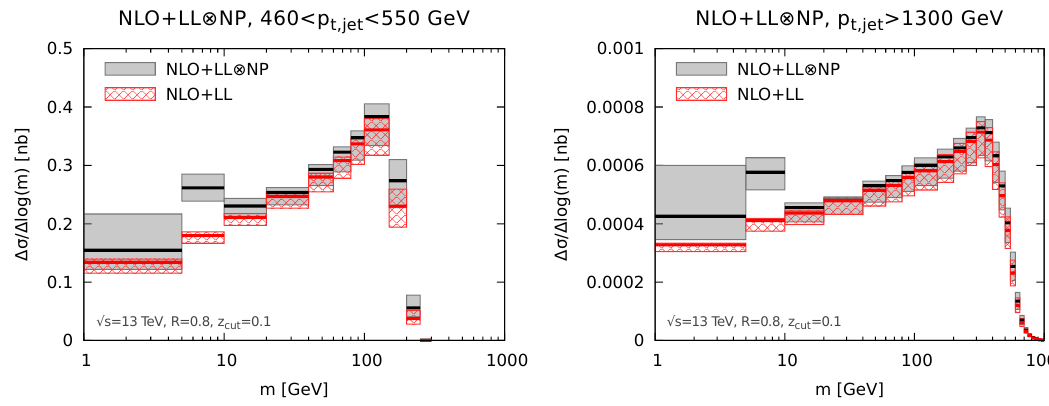
Figure 11 . Final results for the jet mass distribution in the case of the ungroomed p t; jet selec- tion. The perturbative calculation is performed at NLO+LL and non-perturbative corrections are included as a multiplicative factor obtained from Monte Carlo parton showers. Perturbative un- certainties are obtained varying renormalisation, factorisation and resummation scales as detailed in section 3. Non-perturbative uncertainties are obtained considering the spread of (cid:12)ve di(cid:11)erent Monte Carlo tunes, as detailed in section 5. Perturbative and non-perturbative uncertainties are added in quadrature.